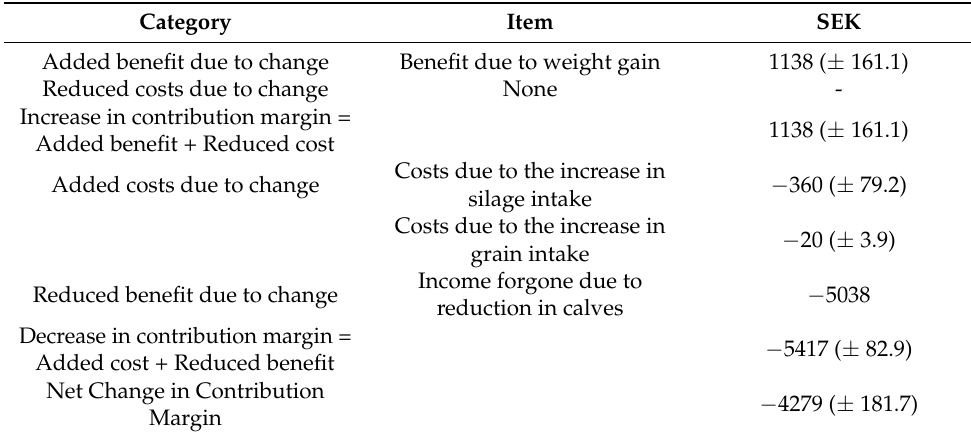
Table 5. Effects a of an increase in space allowance (from 2.2 to 2.7 m 2 /calf)—Scenario 2b.